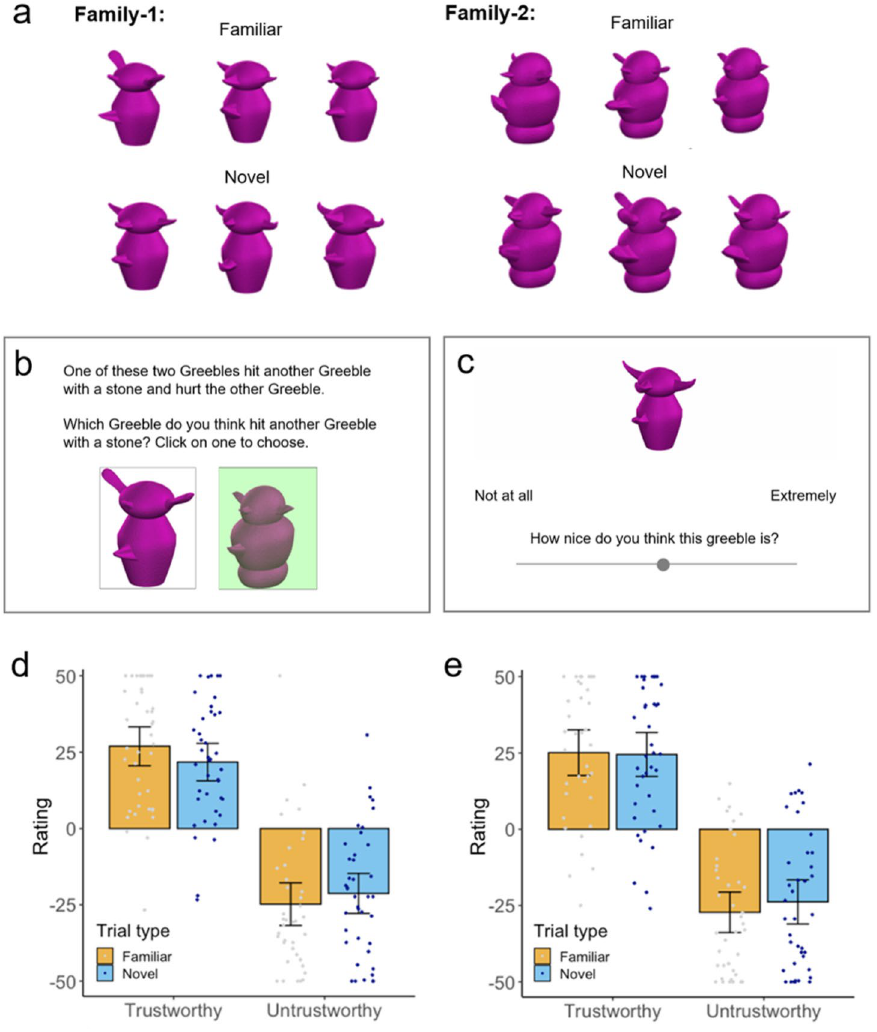
Figure 1. ( a ) The familiar and novel Greebles used in Experiments 1, 2, and 4. ( b ) Example display from a training trial. ( c ) Example display from a test trial. ( d ) Results from Experiment 1. ( e ) Results from Experiment 2. Error bars represent 95% confidence intervals around the mean. Stimulus images courtesy of Michael J. Tarr, Carnegie Mellon University, http:// www. tarrl ab.